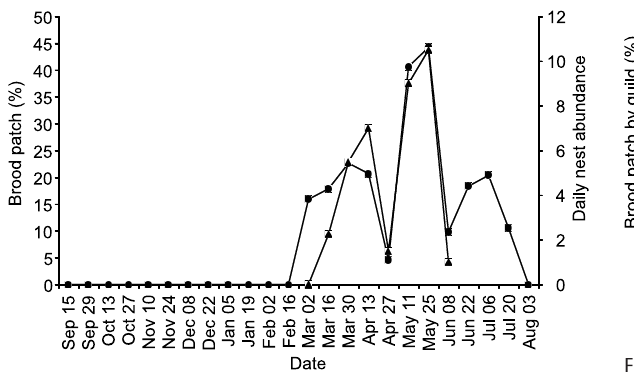
Figure 2. Occurrence of brood patches ( ● ) and nests ( ▲ ) in the Caatinga area studied. The percentage of individuals with brood patches was calculated every netting session as a function of the number of captures. Daily nest abundance (average) calculated from the number of active nests in the seven days before and after each netting session.